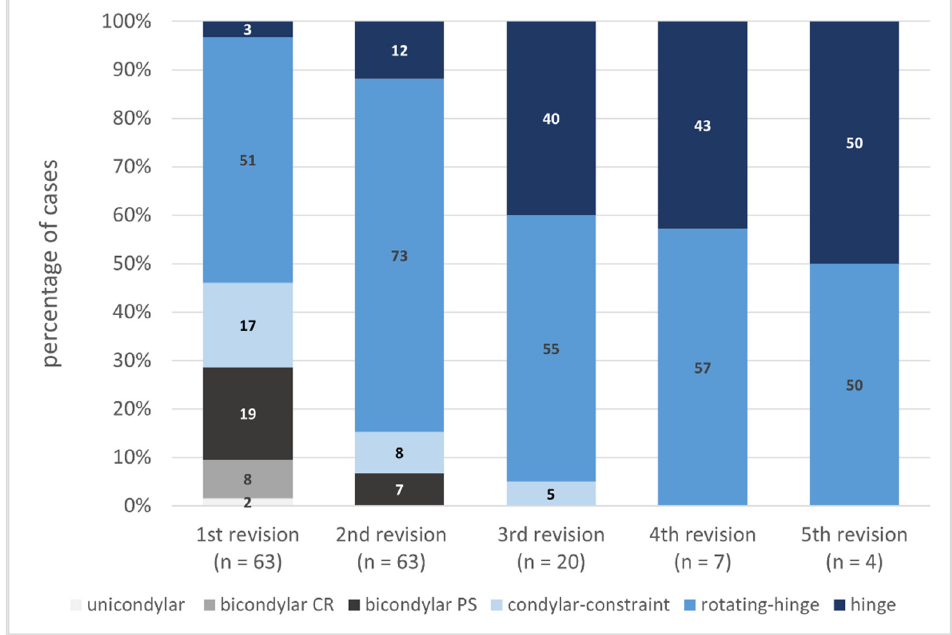
Figure 4. Types of implants used in every revision surgery. There is an increasing percentage of constrained implants with every revision performed. After performing three revisions, nothing but hinge knees were used. CR = cruciate-retaining, PS = posterior stabilized.